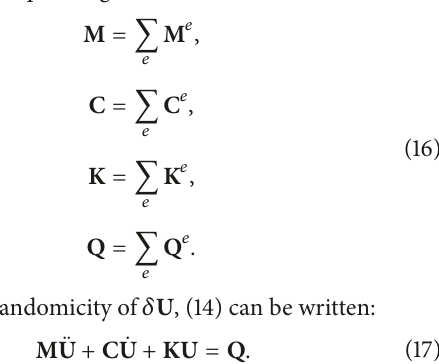
Figure 1: Elastic-plastic behavior of isotropic and kinematic hard- ening